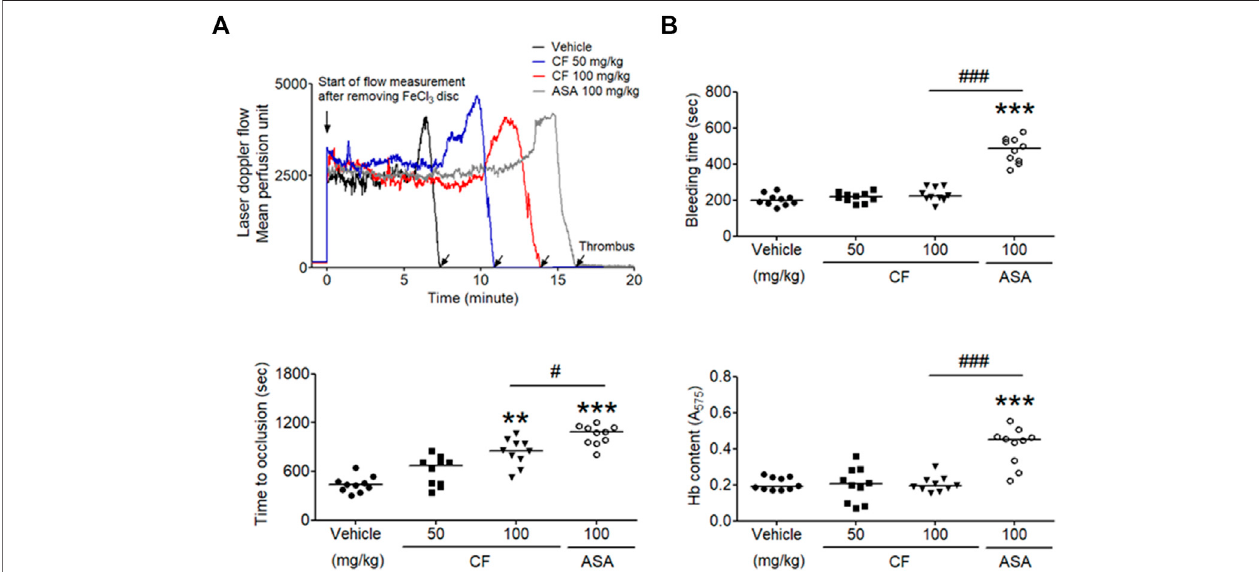
FIGURE 5 | C. fragile delayed FeCl 3 − induced arterial thrombus formation but not hemostasis. FeCl 3 -induced arterial thrombus formation was performed as described in Methods. After oral administration of 0.5% low-viscosity CMC and/or C. fragile (50 or 100 mg/kg, BW) or ASA (100 mg/kg, BW) twice a day for 3 days (A) , the mouse carotid artery was treated with 10% FeCl 3 for 2 min, and blood fl ow traces were monitored until stable occlusion took place. Horizontal bars represent the median occlusion time ( n (cid:2) 10). In the bleeding time assay, tails of the vehicle (circle), a low dose of C. fragile (50 mg/kg, square), a high dose of C. fragile (100 mg/kg, reverse triangle), and ASA (open circle) treated mice were amputated (B) , and the bleeding time and Hb content were monitored as described in Methods. Horizontal bars represent the median of occlusion and bleeding times for each group of animals ( n (cid:2) 10). **: p < 0.01 and ***: p < 0.001 vs. vehicle control and #: p < 0.05 and ###: p < 0.001 between two groups after ANOVA and Turkey ’ s